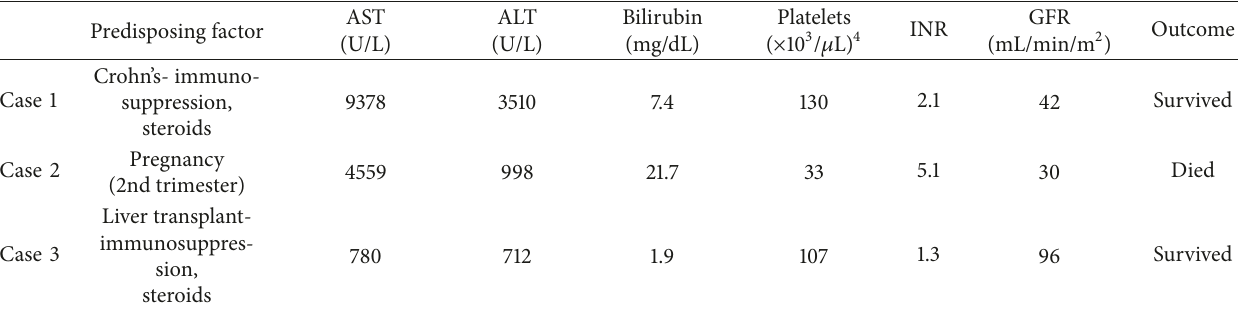
Table 1: Peak/nadir labs and outcomes of patients presented.